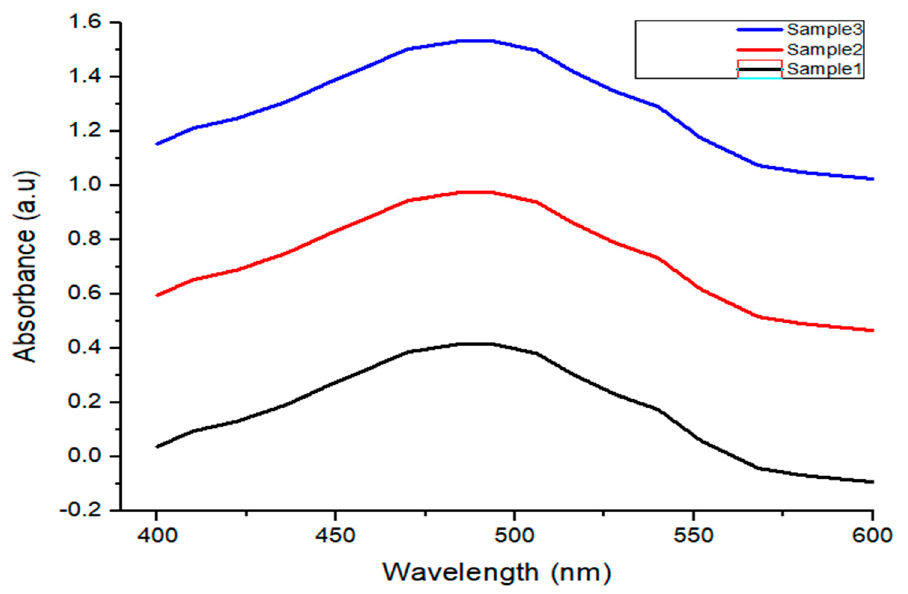
Figure 11. UV–Vis spectra of solutions prepared with different amounts of AuNPs (0.3, 0.4, 0.5